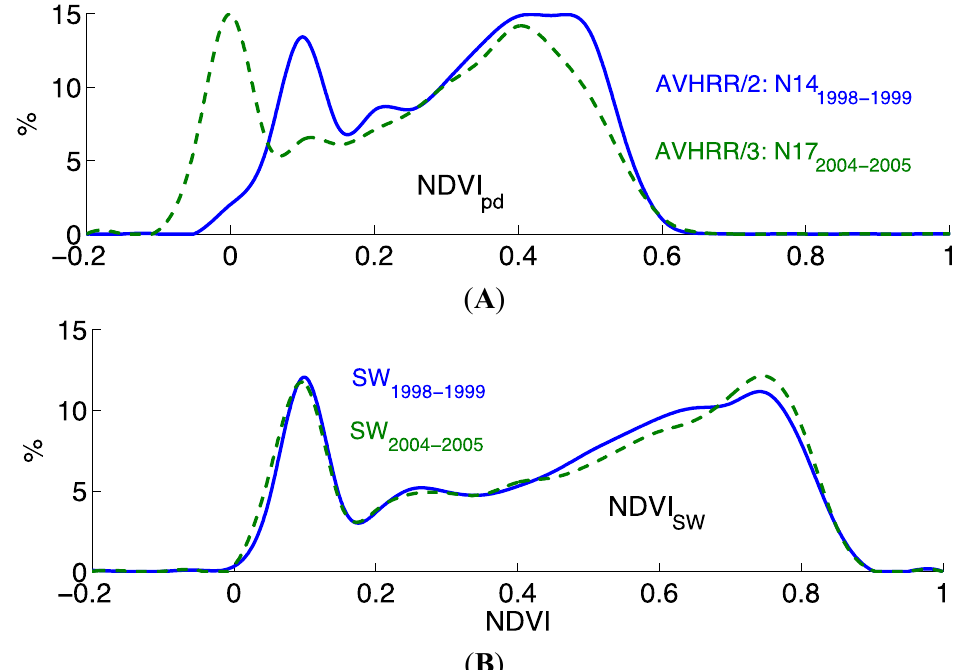
) at two different periods, 1998–1999 and SW